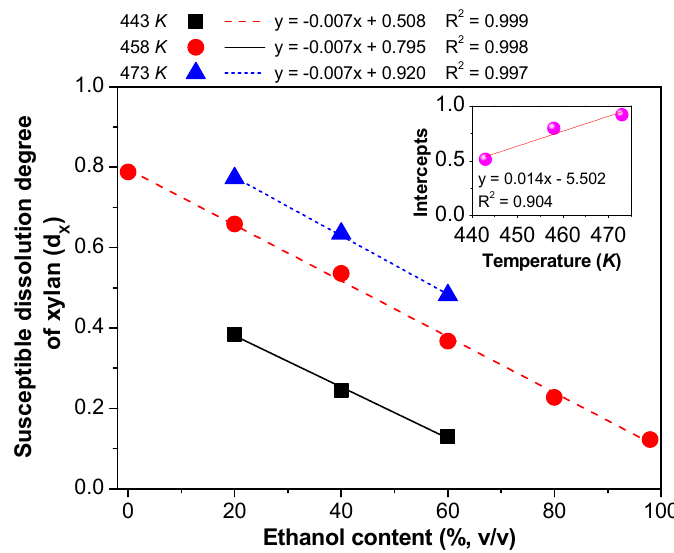
Figure 4. The correlations between d x and ethanol content (%, v/v) in pretreatment liquor at different pretreatment temperatures.